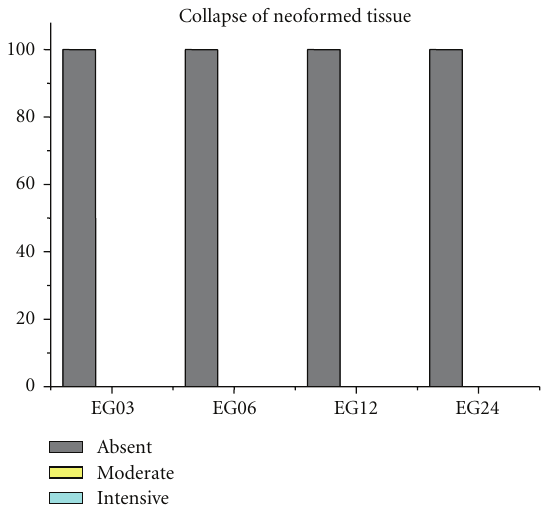
Figure 11: Mineralized bone matrix mean of EGs. Absence: 9%, moderate: 61%, and intensive: 30%.